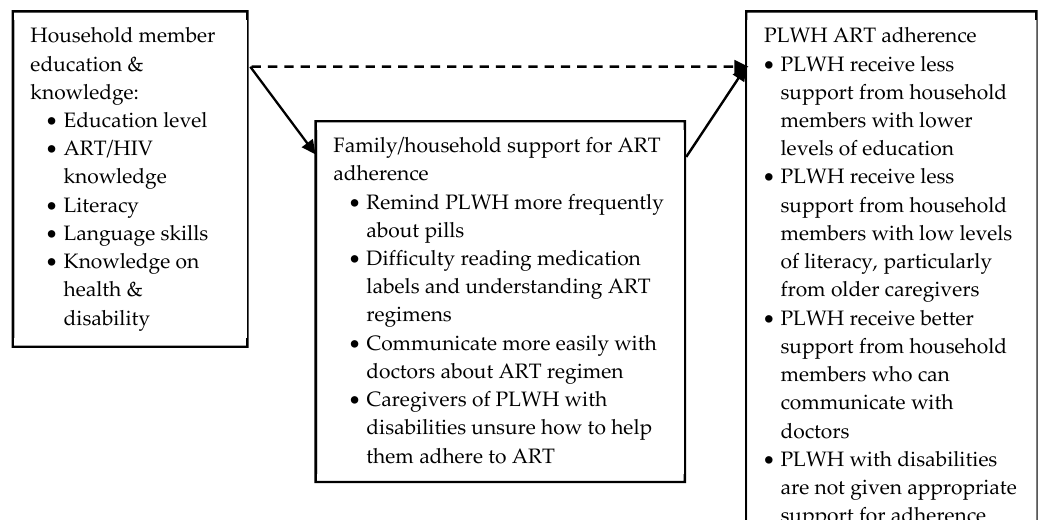
Figure 5. Studies either measured a direct relationship between household member education level and the ART adherence of people living with HIV (PLWH) or examined how this relationship operates via household support .